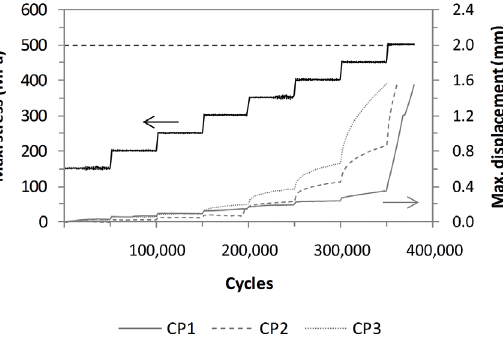
Figure 3. Stepwise load increase plot for the specimens annealed at 450°C.